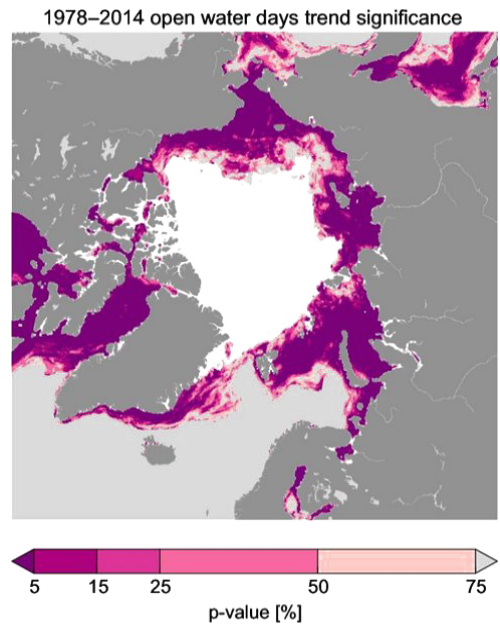
Figure 13. The probability that the trend in Fig. 12 is not significant (test of the null hypothesis). A low value ( < 5%) indicates that the trend is significant.